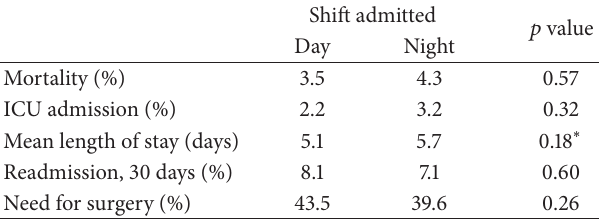
Table 3: Comparison of outcomes between patients admitted during day and night